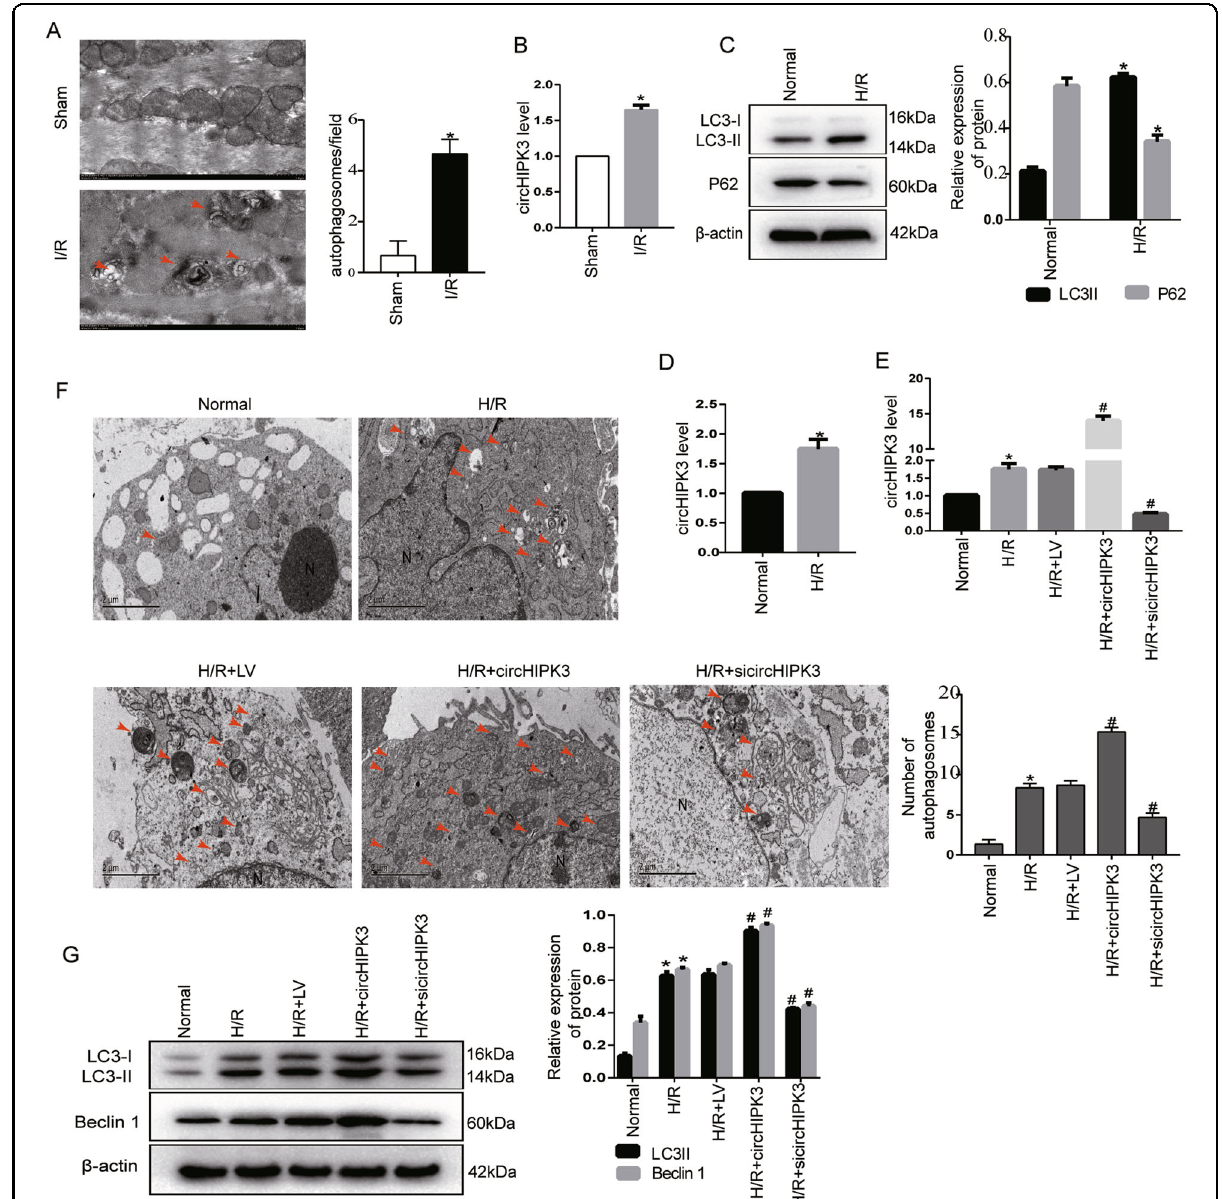
Fig. 1 CircHIPK3 is upregulated concomitantly with accelerated autophagy in hypoxia/reoxygenation (H/R)-stimulated cardiomyocytes and ischemia/reperfusion (I/R)-stimulated myocardium. A Mice were subjected to 60 min of ischemia and 3 h of reperfusion. Representative transmission electron microscopy (TEM) images of hearts show the presence of autophagosomes (red arrow). Scale bar = 1 μ m. B RT-qPCR analysis of circHIPK3 expression in mouse heart samples undergoing I/R or sham treatment. n = 3. C LC3-II and P62 expression were analyzed by western blotting in H/R (6 h hypoxia followed by 4 h reoxygenation)-stimulated cardiomyocytes. n = 3. D Increased expression of circHIPK3 in H/R-stimulated cardiomyocytes. n = 9. E Cardiomyocytes were transfected with negative control (LV), circHIPK3 overexpression vector, or circHIPK3 siRNA (si- circHIPK3) for 48 h. F Representative electron microscope analysis of autophagosomes in cardiomyocytes. Scale bar = 2 μ m. G LC3-II and Beclin 1 expression were analyzed by western blotting in cardiomyocytes. * P < 0.05 compared with the sham or normal group. # P < 0.05 compared with the H/R